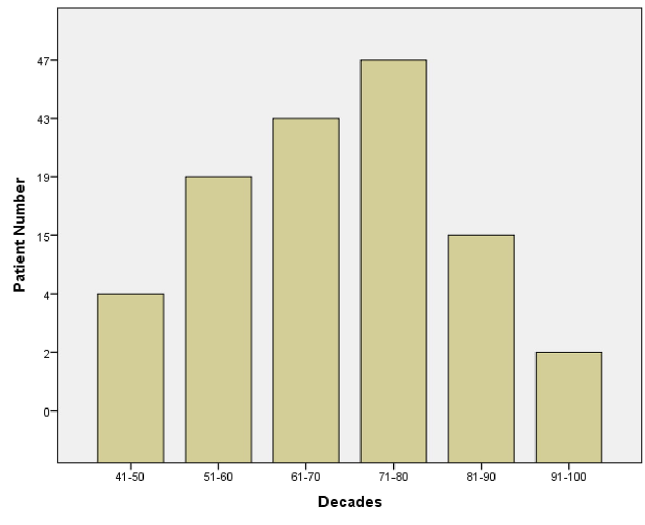
Figure 1. The number of calcified Peyronie’s plaques according to patient age by a